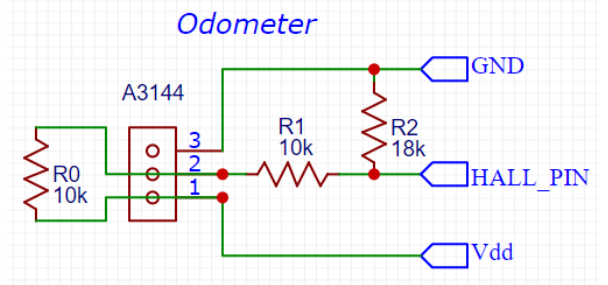
Figure 22. Voltage divider used to reduce the voltage of the odometer’s output signal.